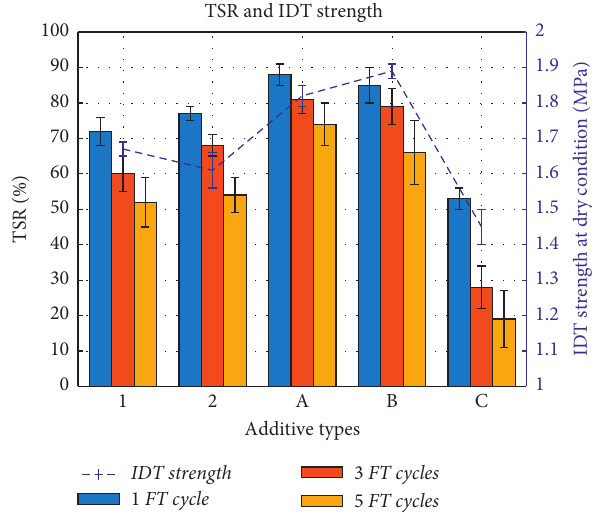
Figure 6: TSR and IDT strength of moisture-damaged mixtures.